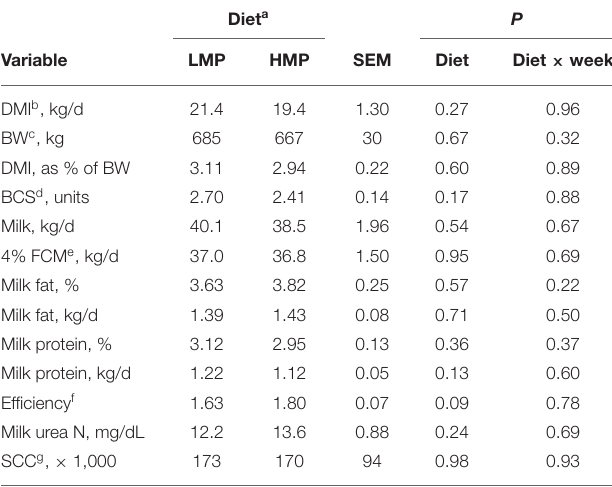
TABLE 4 | Postpartum variables for cows fed low (L) or high (H) amounts of metabolizable protein (MP) prepartum. Diet